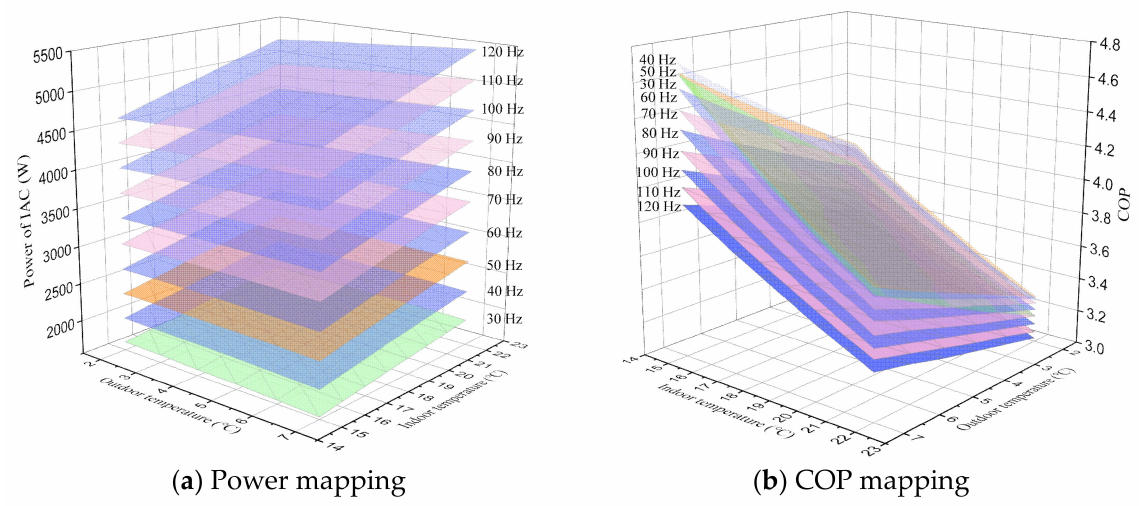
Figure 5. Performance maps of